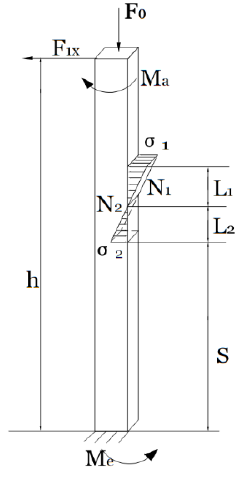
Figure 5. Force analysis of the pillar.